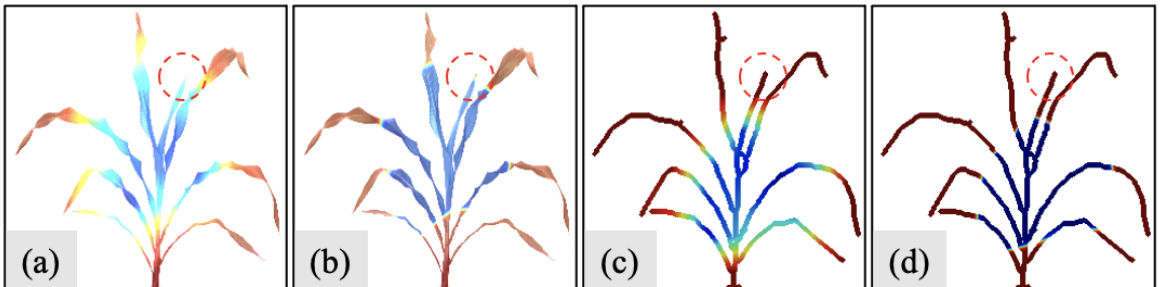
Figure 9. Heatmaps from Grad-CAM method for datasets S1: ( a ) heatmap derived from Figure 5a; ( b ) emphasized heatmap derived from Figure 5a; ( c ) heatmap derived from Figure 5c; ( d ) emphasized heatmap derived from Figure